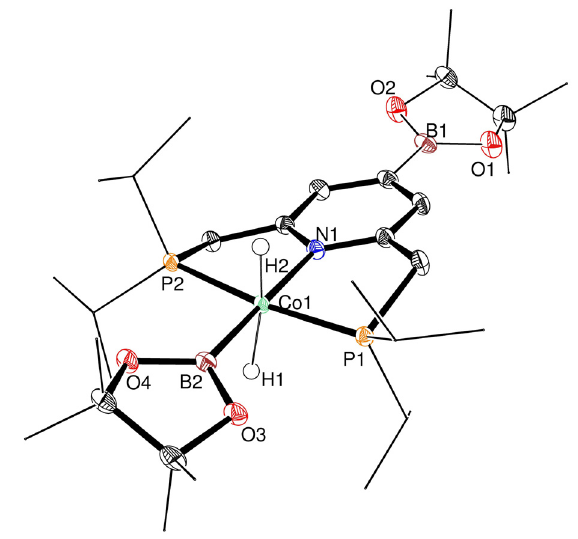
Fi gur e 4. 1 . OR T EP s t ruc t ure of t he ca t alys t res ti ng s t a t e CoXX II . A dap t ed from